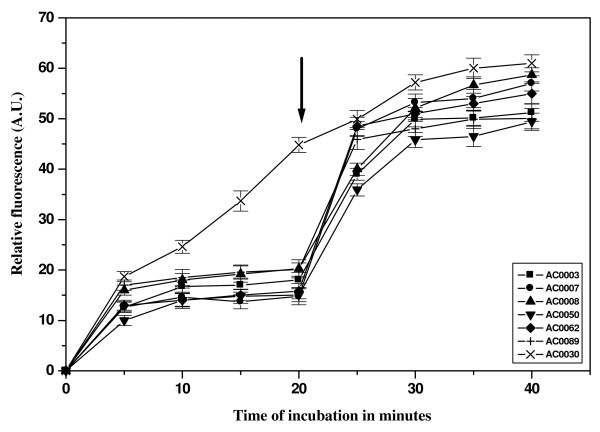
Accumulation studies with ciprofloxacin. The fluorescence of the supernatant was measured with spectroflourimeter (LS 55 Fluorescence Spectrometer, 120 V, Perkin-Elmer model) at an excitation 275 nm and emission 440 nm for ciprofloxacin. The results for six representative MDR strains, namely, AC0003, AC0007, AC0008, AC0050, AC0062, AC0089 and one sensitive strain AC0030 are shown here. The graphs reflect the difference in fluorescence displayed by the bacterial cell in the presence and absence of efflux pump inhibitor CCCP. The arrow indicates the time of addition of CCCP. All experiments were carried out at least three times.